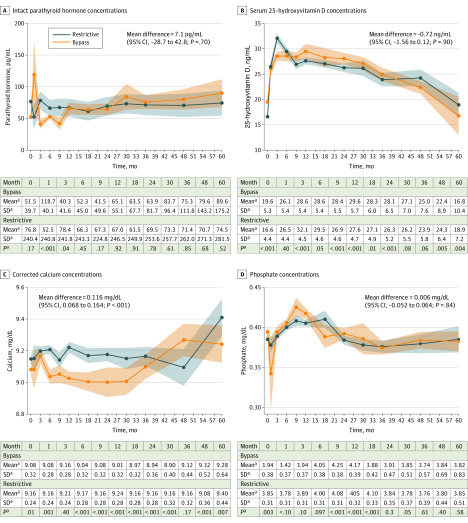
Five-year Trajectories in Serum Hormone and Micronutrient ConcentrationsSI conversion factors: To convert parathyroid hormone level to nanograms per liter, multiply by 1; 25-hydroxyvitamin D level to nanomoles per liter, multiply by 2.496; calcium to millimoles per liter, multiple by 0.25; and phosphate to millimoles per liter, multiply by 0.323.aEstimated margins and 95% CIs are plotted immediately after fitting inverse probability of treatment weighted linear mixed models conditioned on the treatment propensity score and additionally adjusted for sex. Restrictive includes patients who underwent laparoscopic sleeve gastrectomy; bypass includes patients who underwent laparoscopic Roux-en-Y gastric bypass or one-anastomosis gastric bypass.